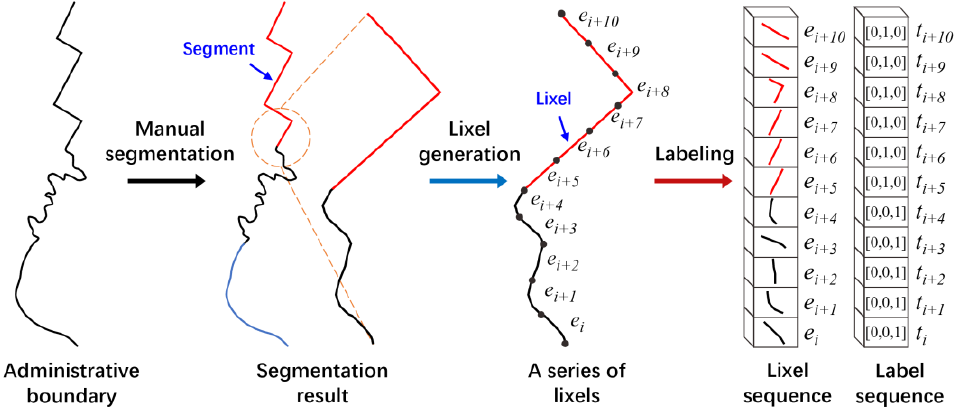
Figure 4. Lixel generation and labeling for each administrative boundary. Blue, red, and black colors of the divided segments indicate SIS, SRS, and SIN patterns, respectively.